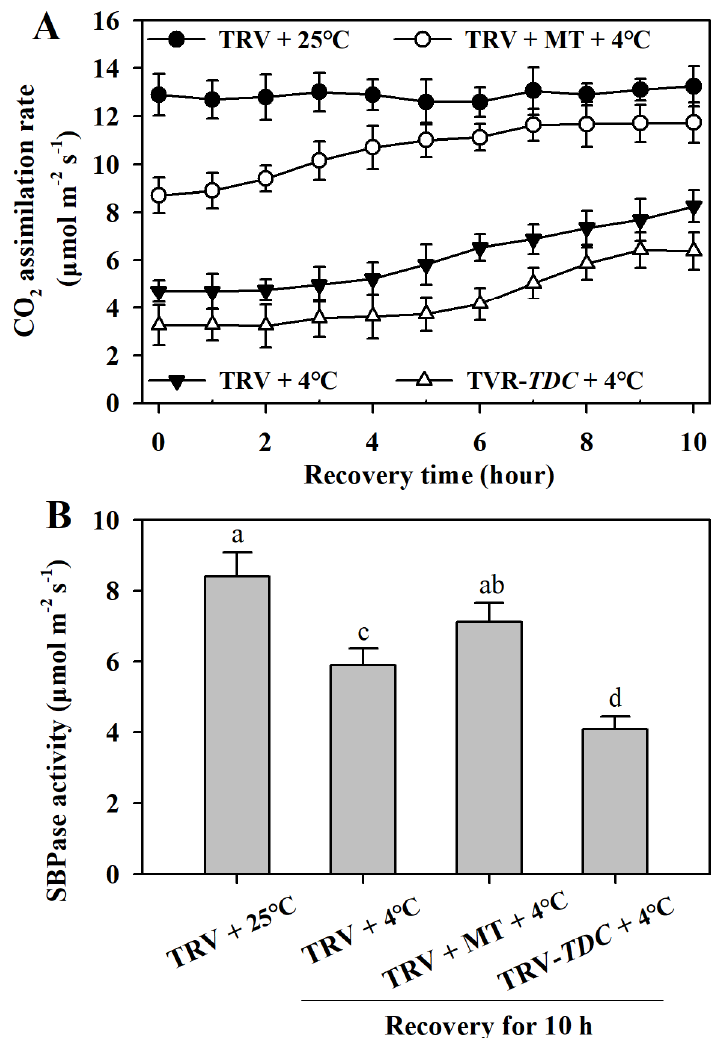
Figure 7. Melatonin accelerates the recovery of photosynthesis ( A ) and the restoration of SBPase activity ( B ) in chilling-stressed tomato plants. Following a 12-h chilling stress, tomato plants were placed back at 25 °C for 10 h for the determination of photosynthesis recovery. Photosynthetic carbon assimilation rates of tomato leaves were measured at 1 h intervals. SBPase activities were assayed at hour 10. The values presented are means ± SDs ( n = 3). Different letters (a–d) above bars indicate significant difference at p < 0.05 among treatments.